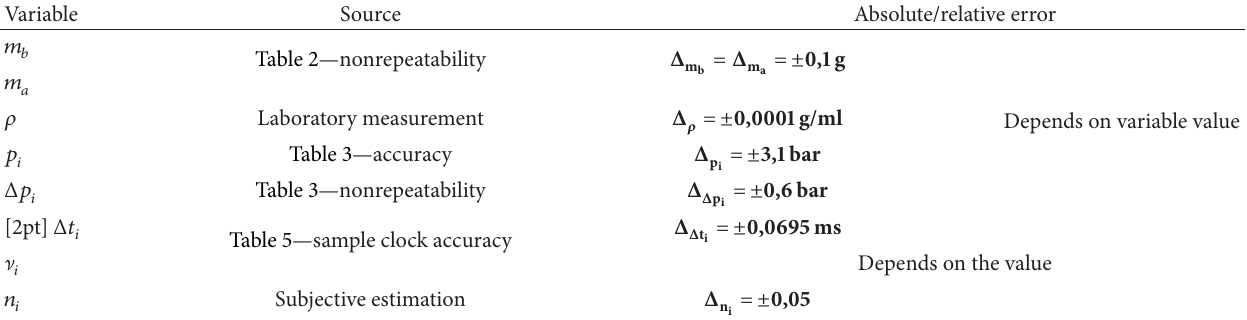
Table 7: Absolute and relative errors of variables that varied throughout a single measurement.